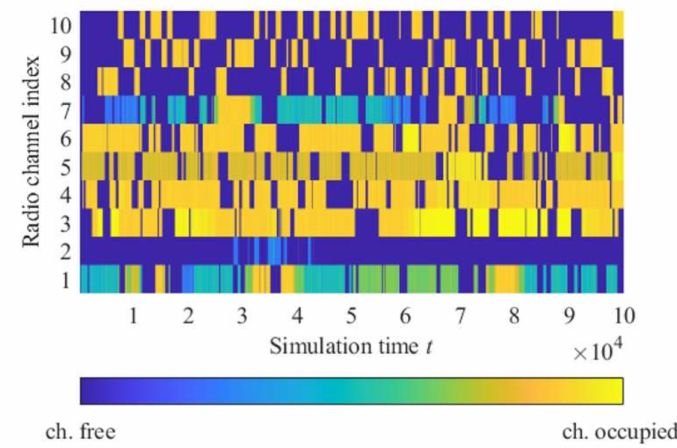
Figure 11. Aggregated monitoring results for all